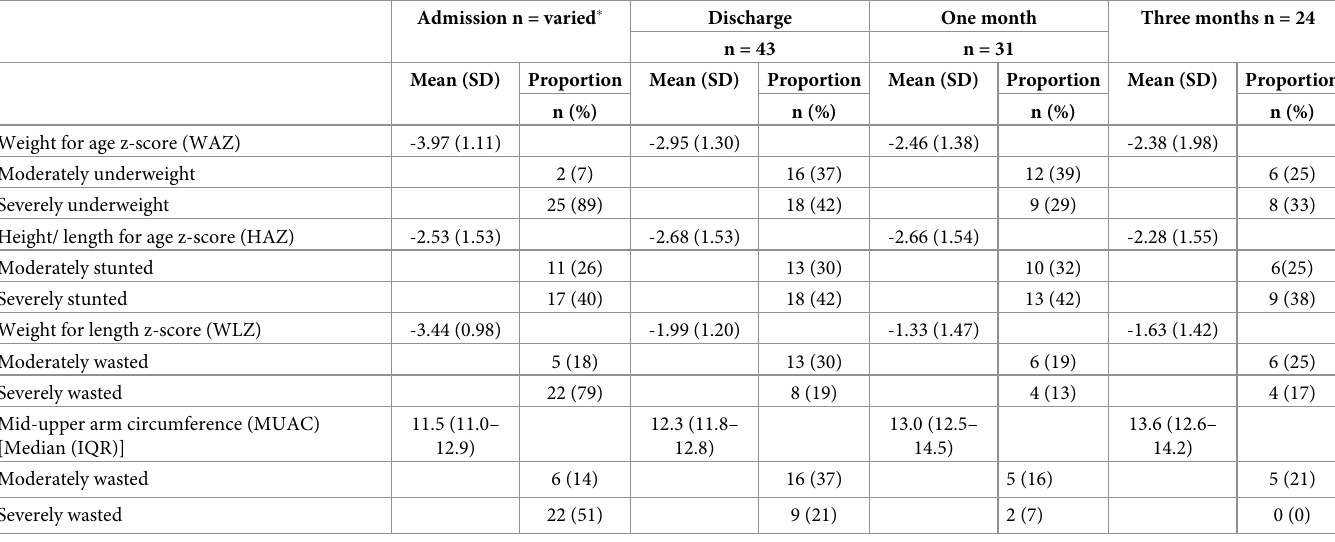
Table 2. Anthropometry at discharge, one month and three month follow up.